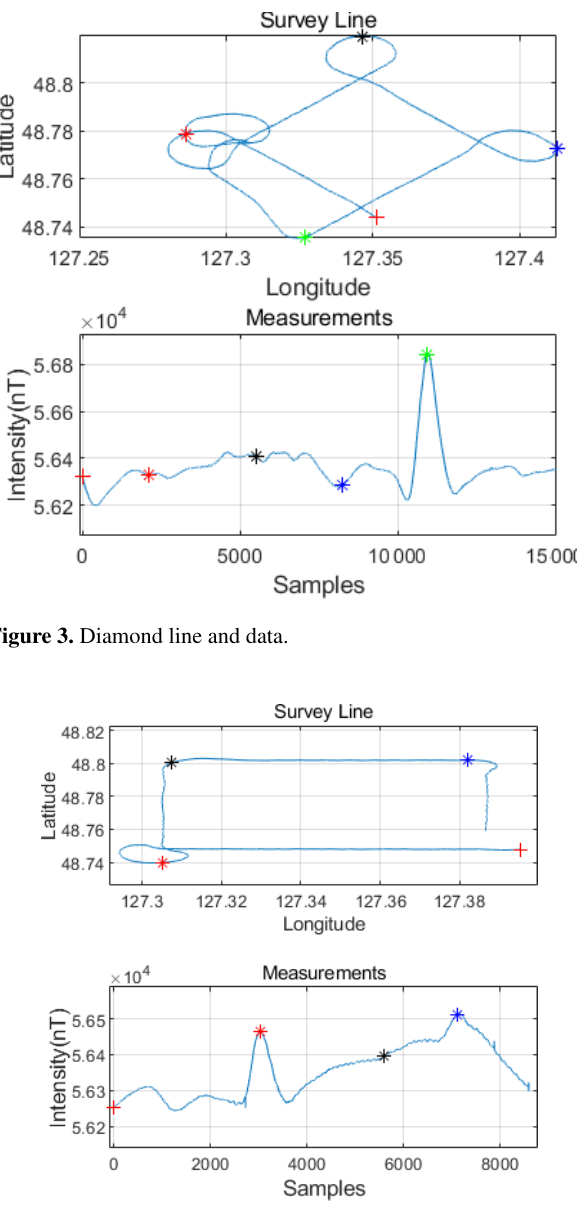
Figure 4. Square line and data.